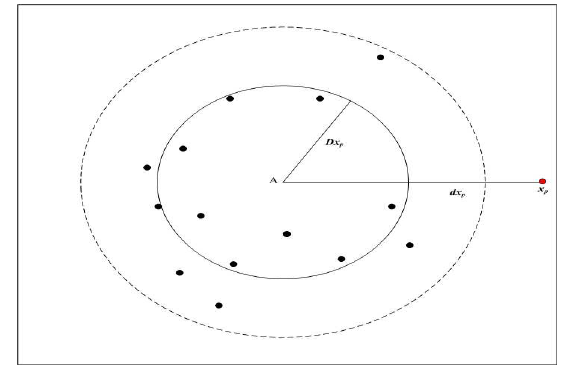
Figure 5. The explicit outlierness of object p LDOF definition. A is the center of the neighborhood system of p i . The dashed circle includes all neighbors of p i . The solid circle is reformed neighborhood region of p